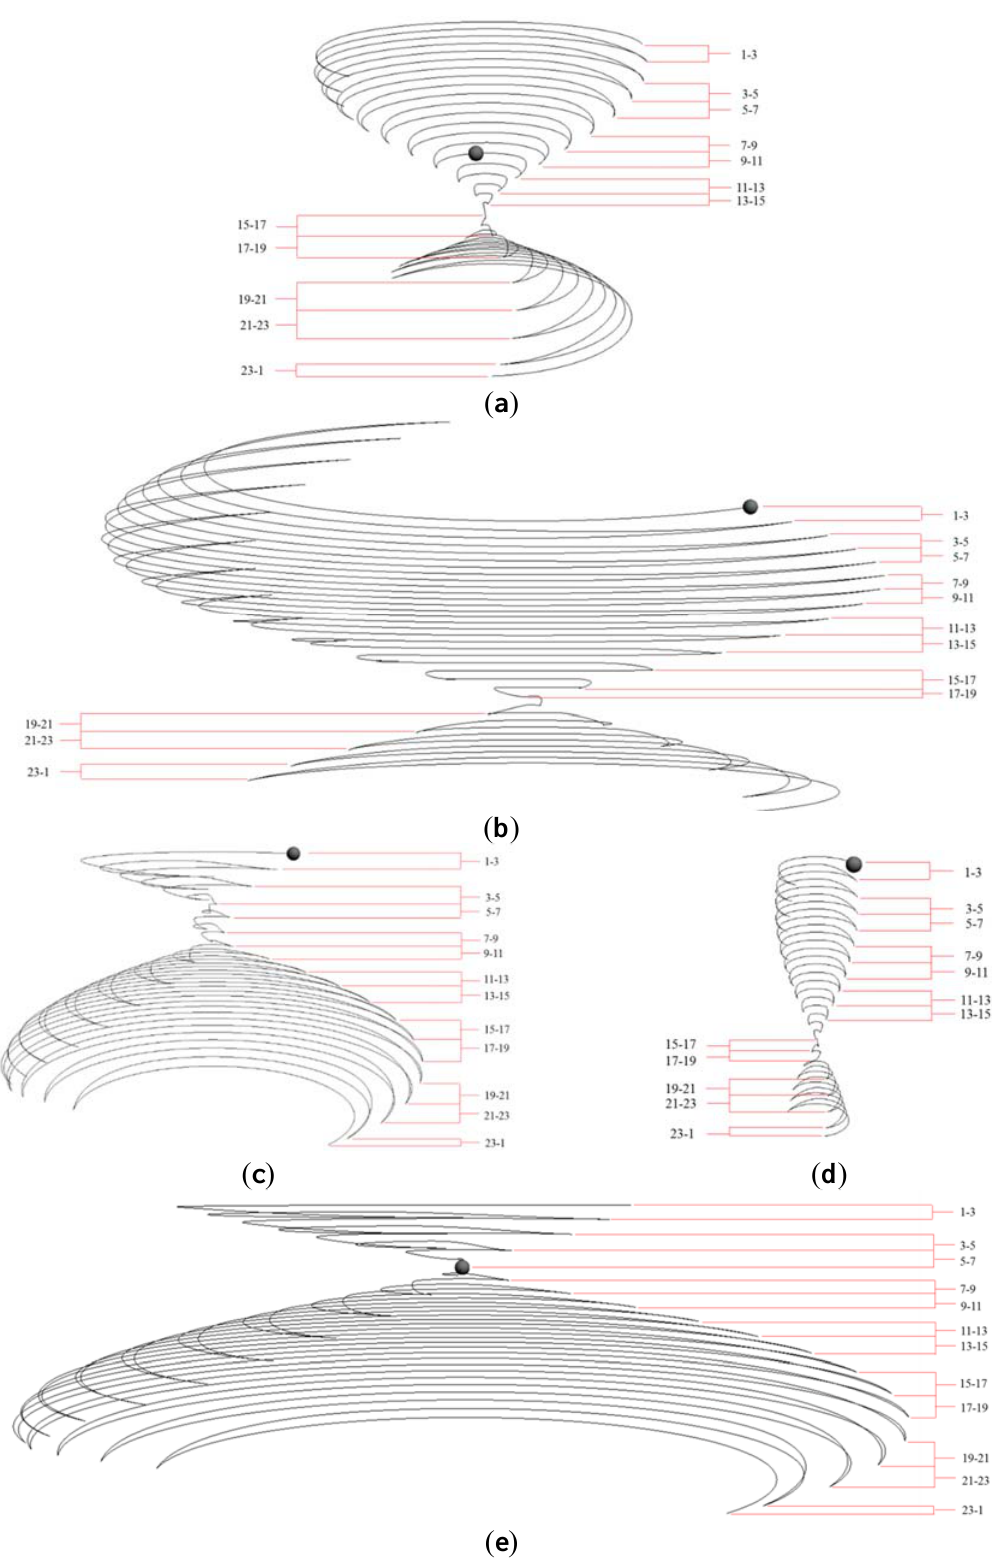
Figure 3. Animation diagram of the physiological performance over a 24-h period. The various time points (from top to bottom) refer to the meridian performances in every official ( i.e ., the liver, lungs, large intestine, stomach, spleen, heart, small intestine, bladder, kidneys, pericardium, sanjiao , and gallbladder): ( a ) mean value